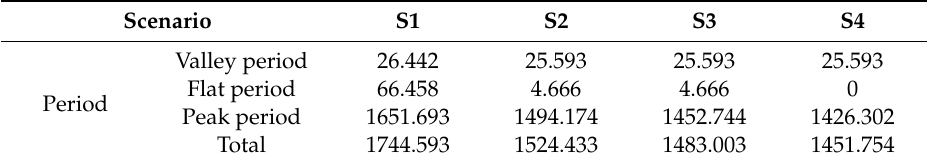
Table 8. GFG costs during different periods (Unit: $)